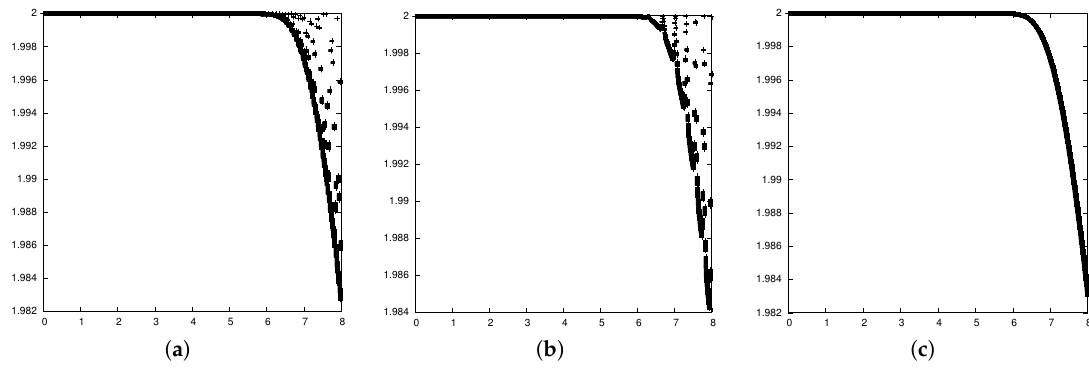
Figure 3. Bifurcation diagram of System (2) with initial conditions ( a ) 0.05, ( b ) 0.19, ( c ) 1.7. Horizontal axis is α and vertical axis is x n . n > 3000 for ( a ) and n > 8000 for ( b , c